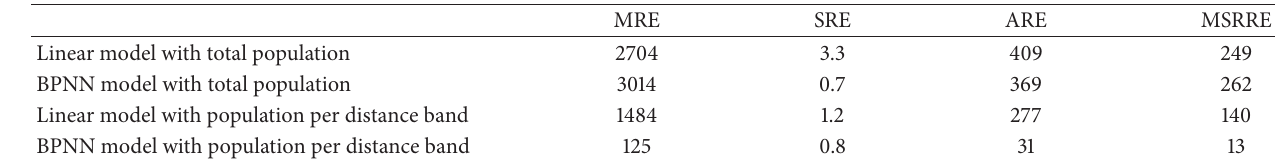
Table 6: MOEs of four models.